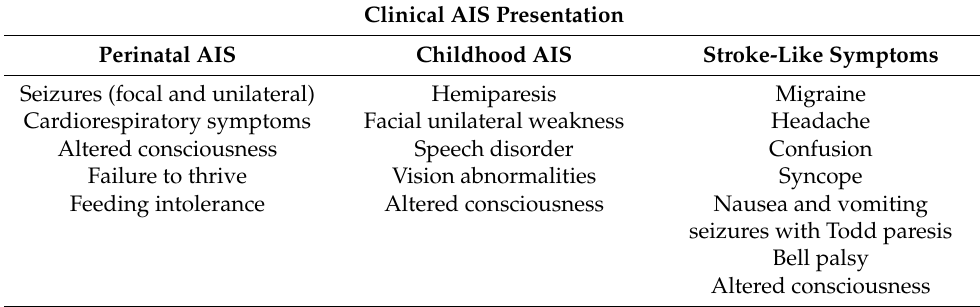
Table 2. Possible clinical AIS presentation.